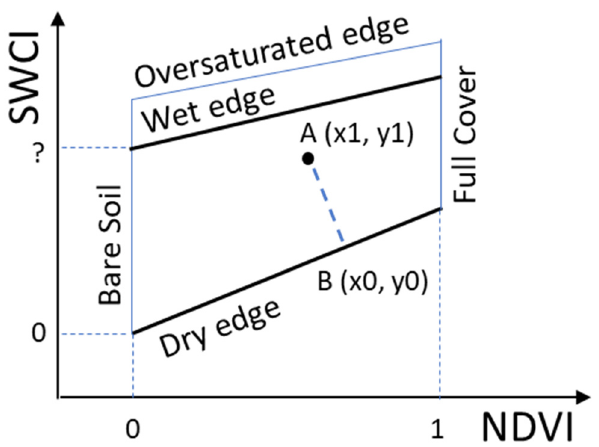
Figure 4. Trapezoidal spectral space, assumed to be between SWCI and NDVI. The figure is adopted from Sadeghi et al. [86].